Question: Give a one-sentence summary of this figure.
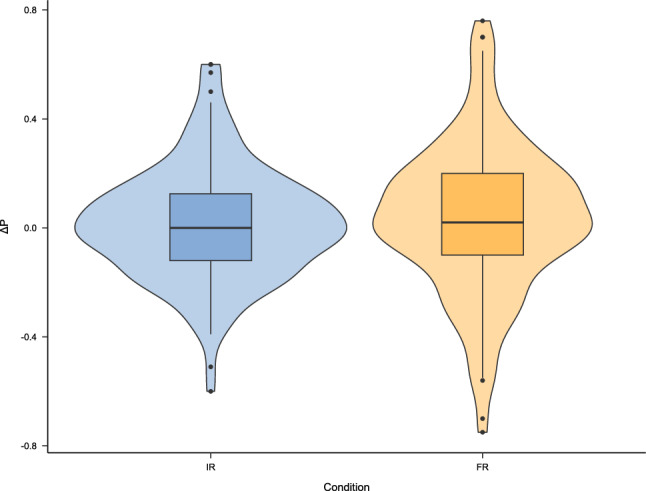
Answer: Distribution of final contingency estimates per condition in Experiment 1. Note. Contingency estimates were calculated for the strength of the association between the most frequent option and the most frequent outcome